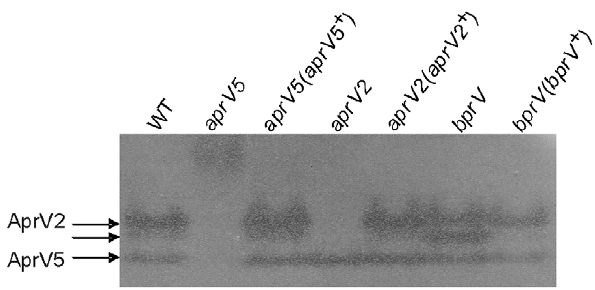
Figure 1. Zymogram analysis of extracellular protease activity. Gelatin was used as a substrate overlay of supernatants separated by native polyacrylamide gel electrophoresis [32] to screen AprV5 and AprV2 activity in 25 h TAS broth cultures from the wild-type strain VCS1703A (WT), the aprV5 mutant JIR3756 ( aprV5 ), the aprV2 mutant JIR3743 ( aprV2 ), the bprV mutant JIR3928 ( bprV ) and the complemented